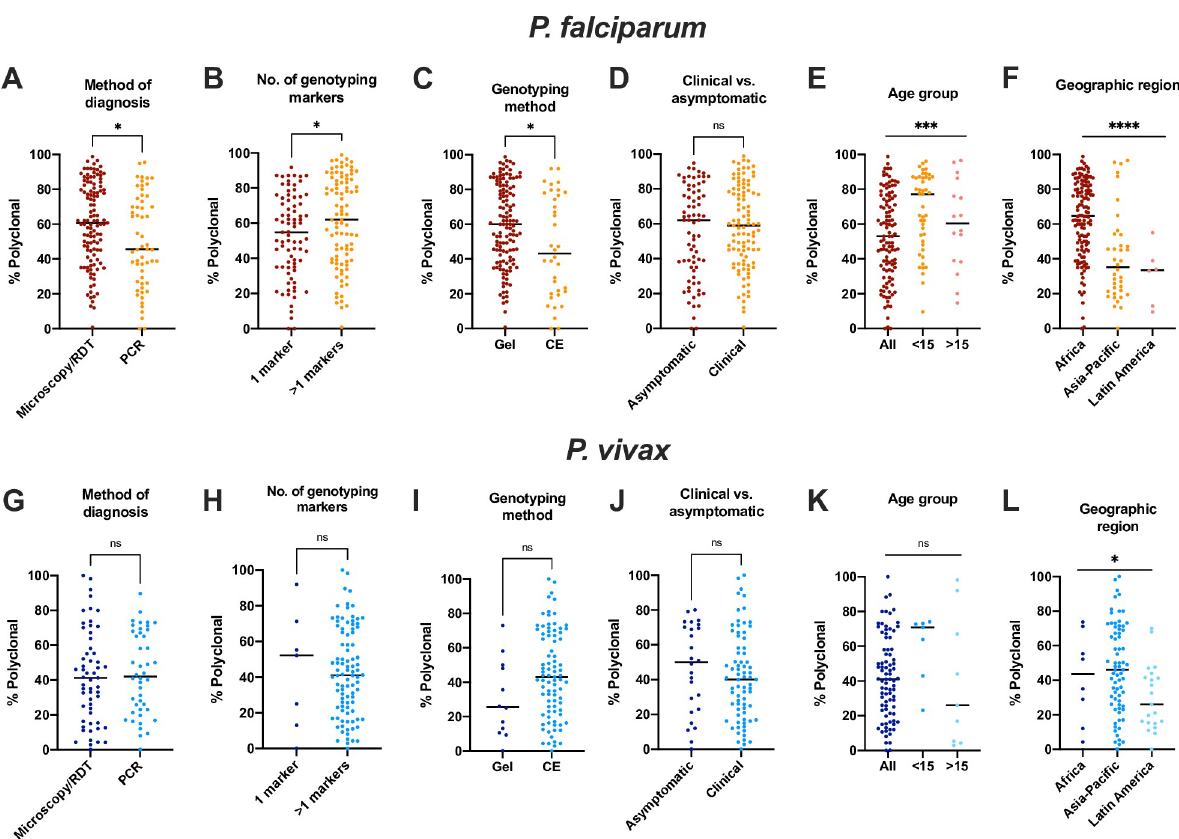
Fig 3. Impact of presence of laboratory methods (method for diagnosis, number of genotyping markers, method to size size-polymorphic amplicons) and patient characteristics (presence of clinical symptoms, age group, geographic region) on the proportion P. falciparum (A-F) and P . vivax (G-L) polyclonal infections. Black line denotes median. Groups were compared by Mann-Whitney test (if 2 groups), or regression analysis (if 3 groups). � P � 0.05, �� P � 0.01, ��� P � 0.001, ���� P � 0.0001, ns = not